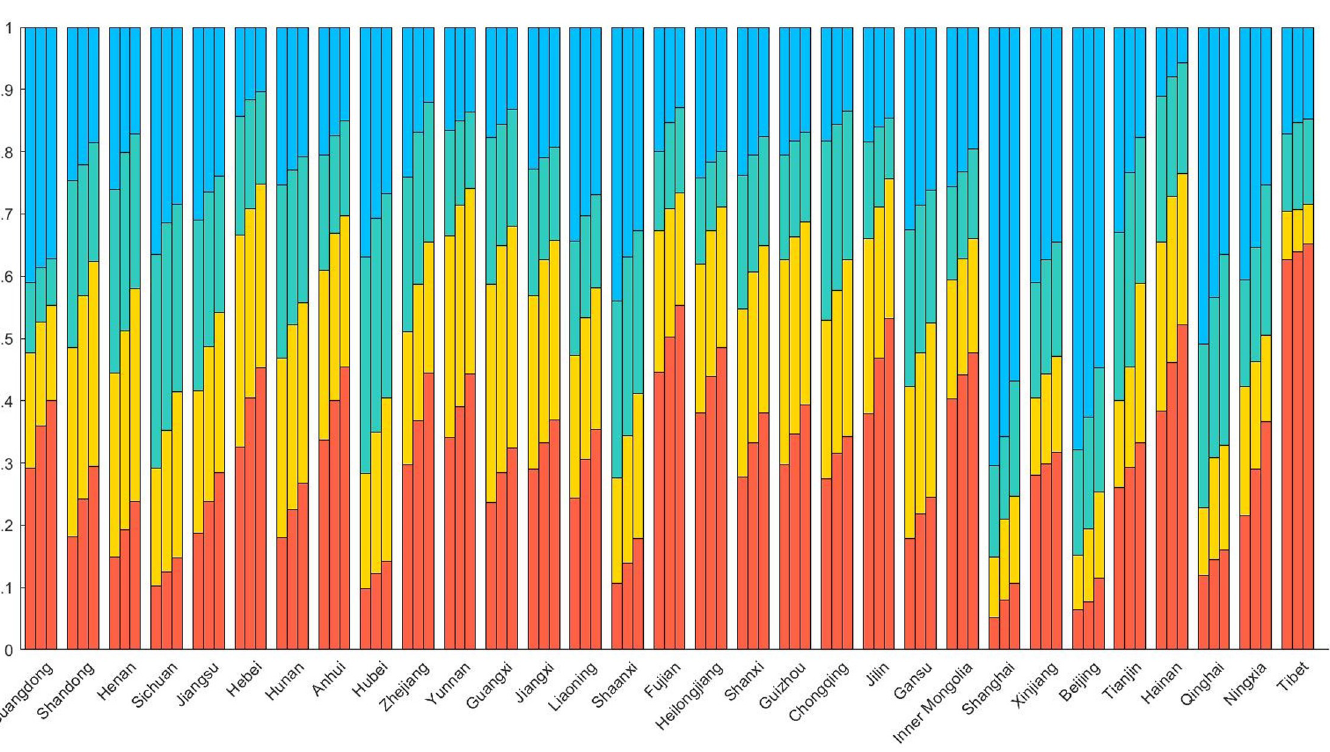
Fig 4. The proportion of population under different accessibility types of three scenarios in each